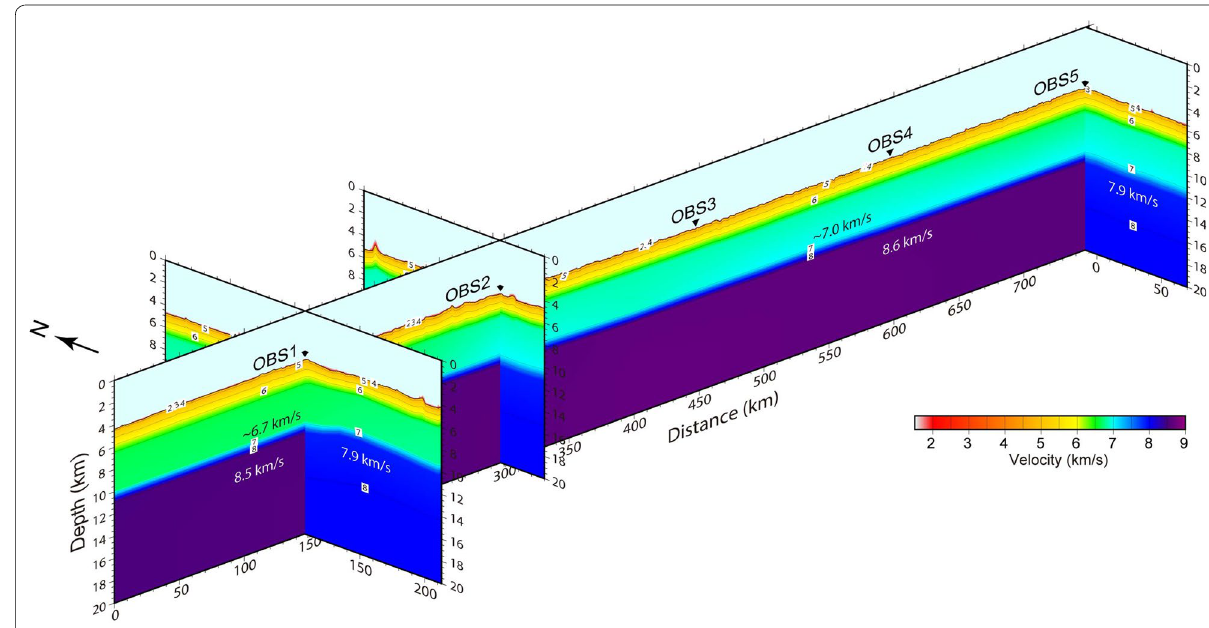
Fig. 9 P -wave velocity structure obtained from the forward